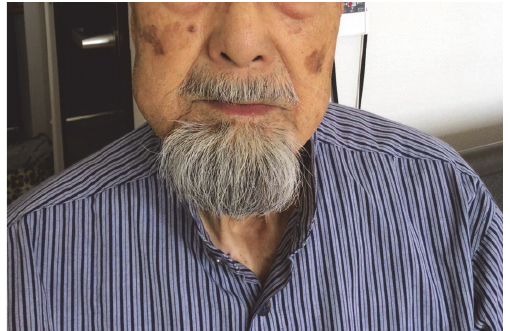
Figure 1: Swelling was seen in the right cheek.